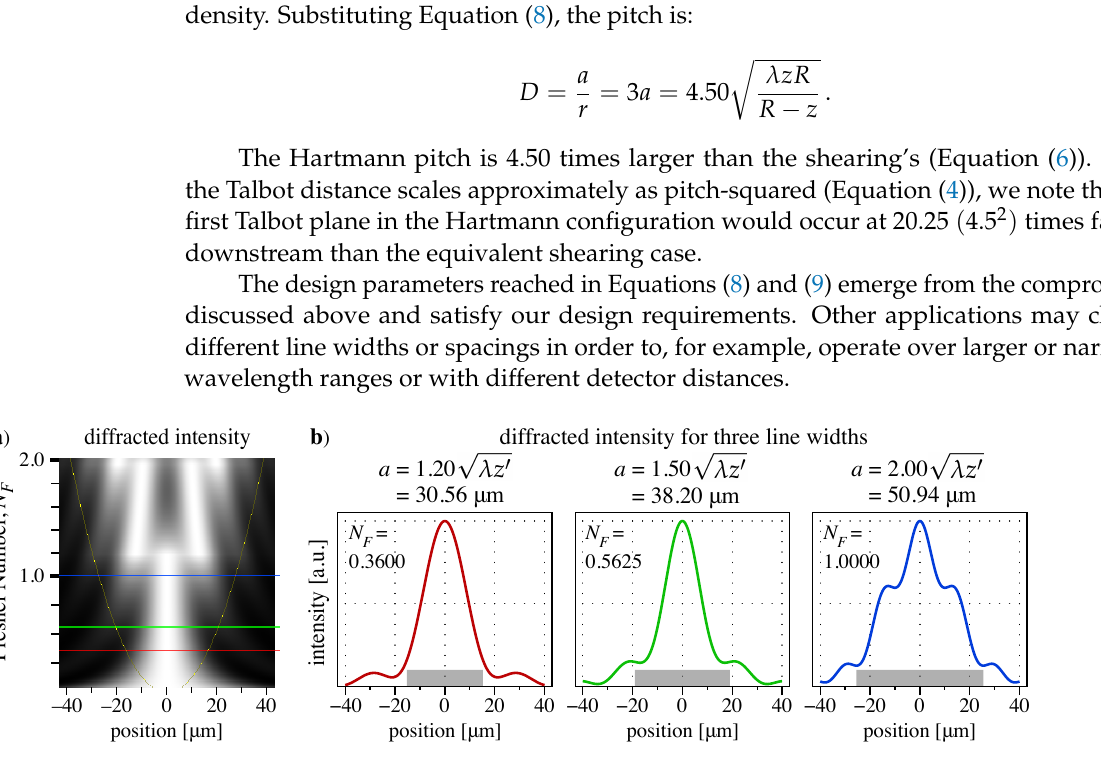
Figure 2. Diffracted intensity patterns from a range of isolated Hartmann-grid line widths calculated with respect to the Fresnel number, N F = a 2 /4 λ z (cid:48) , with fixed wavelength, λ = 2nm, detector distance, z = 0.3m, and incident beam radius, √ R = 4m. Note that λ z (cid:48) = 25.469µm. ( a ) Each row is calculated independently and normalized to its maximum value. Yellow curves show the line width, references to the horizontal axis. Red, green, and blue lines show the positions of three specific diffracted intensity calculations ( b ) extracted from the plot. Gray rectangles represent the line width in each